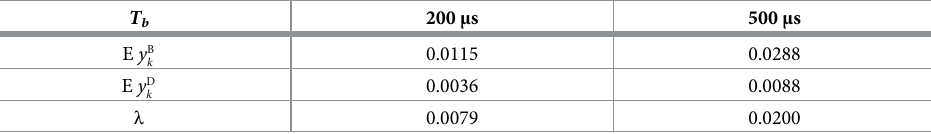
Table 1. Mean values of mung beans signal and noise.